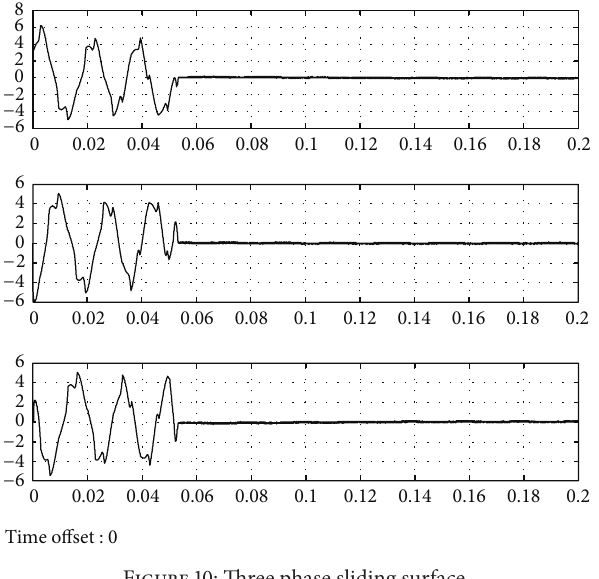
Figure 10: Three phase sliding